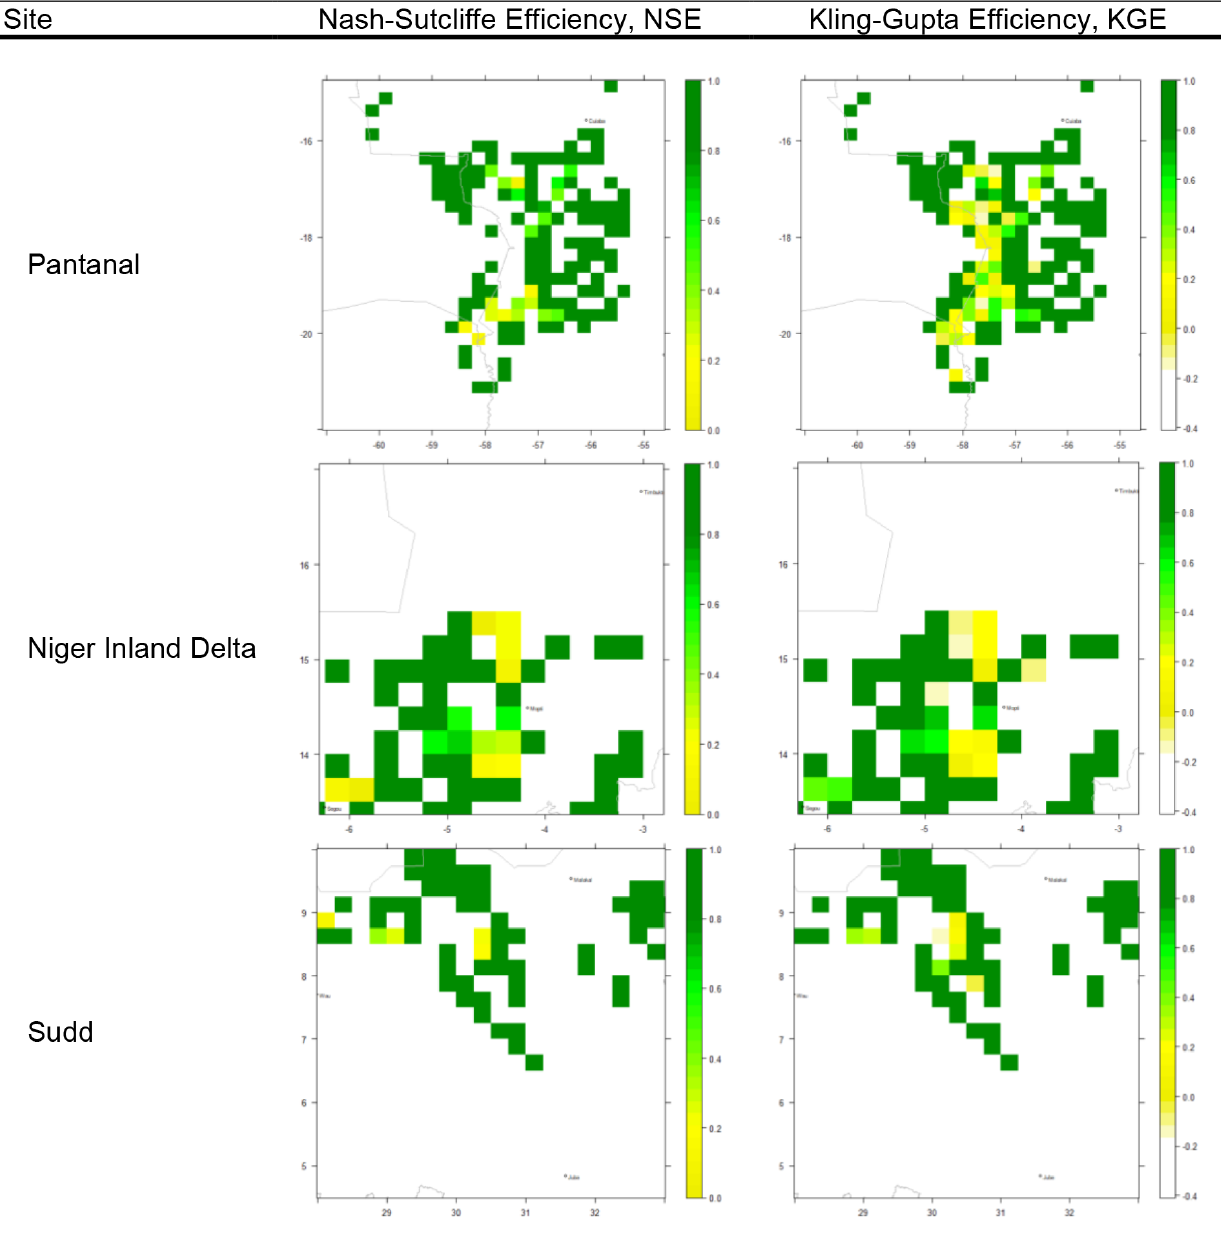
CaMa-Flood flood extent and GIEMS wetland extents